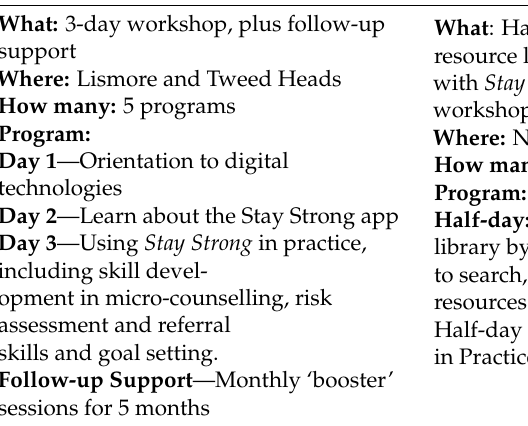
Table 2. The University Centre for Rural Health training programs and the WellMob website. R U Appy